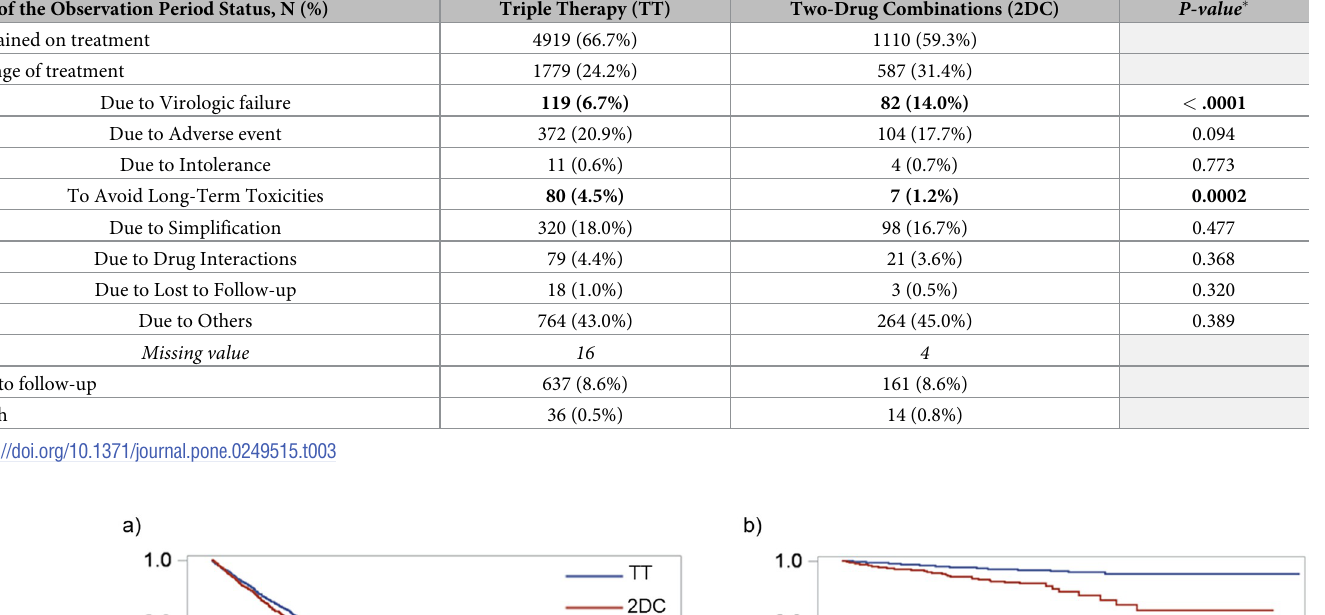
PLOS ONE | https://doi.org/10.1371/journal.pone.0249515 April 8,